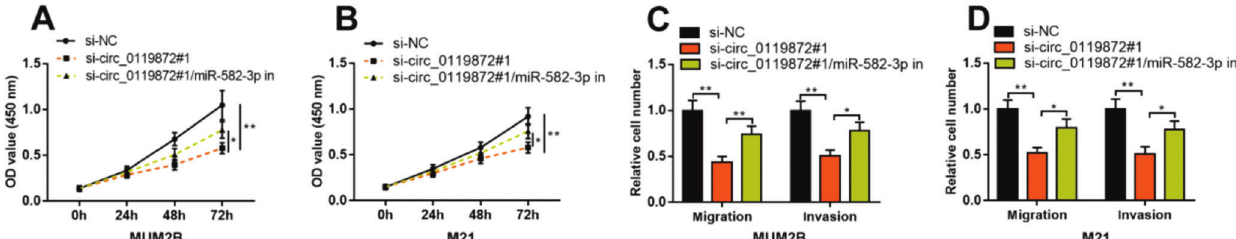
Figure 4 - MiR-582-3p inhibitors partially reverse the inhibitory effects of the knockdown of circ_0119872 on MM cell proliferation, migration, and invasion. (A,B) CCK-8 assay was employed to detect the MM cell proliferation after co-transfection with si-circ_0119872#1 and miR-582-3p inhibitors. (C,D) Transwell assay was performed to detect the MM cell migration and invasion after co-transfection with si-circ_0119872#1 and miR-582-3p inhibitors. * p o 0.05 and ** p o 0.01. axis (16). Circ_0119872 is a circRNA derived from the tran- script of the RASGRP3 gene, located on chromosome chr2:33736776-33740273. A recent study reported that circ_ 0119872 promotes the malignancy of uveal melanoma cells by regulating the miR-622/G3BP1 axis (17). In the present study, circ_0119872 was found to be expressed at remarkably higher levels in MM tissue specimens than in normal tissues, and knocking down circ_0119872 suppressed the prolifera- tion, migration, and invasion of MM cells, which is consistent with a previous report (17).